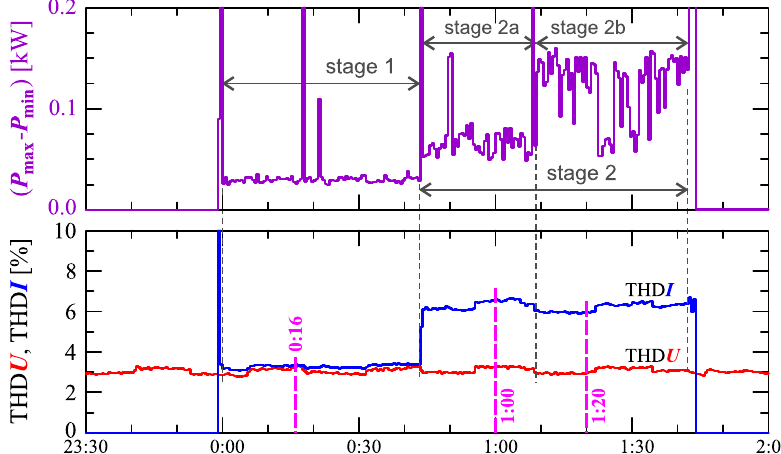
Figure 6. The differences between the maximum and minimum active power ( P max − P min ) = f ( t ) (top), and the voltage THD factor THD U = f ( t ) and current THD factor THD I = f ( t ) (bottom) with the marking of measurement results presented on the waveforms (Figure 11) and amplitude spectra (Figure 10) recorded at 0:16, 1:00, and 1:20 for Case I.